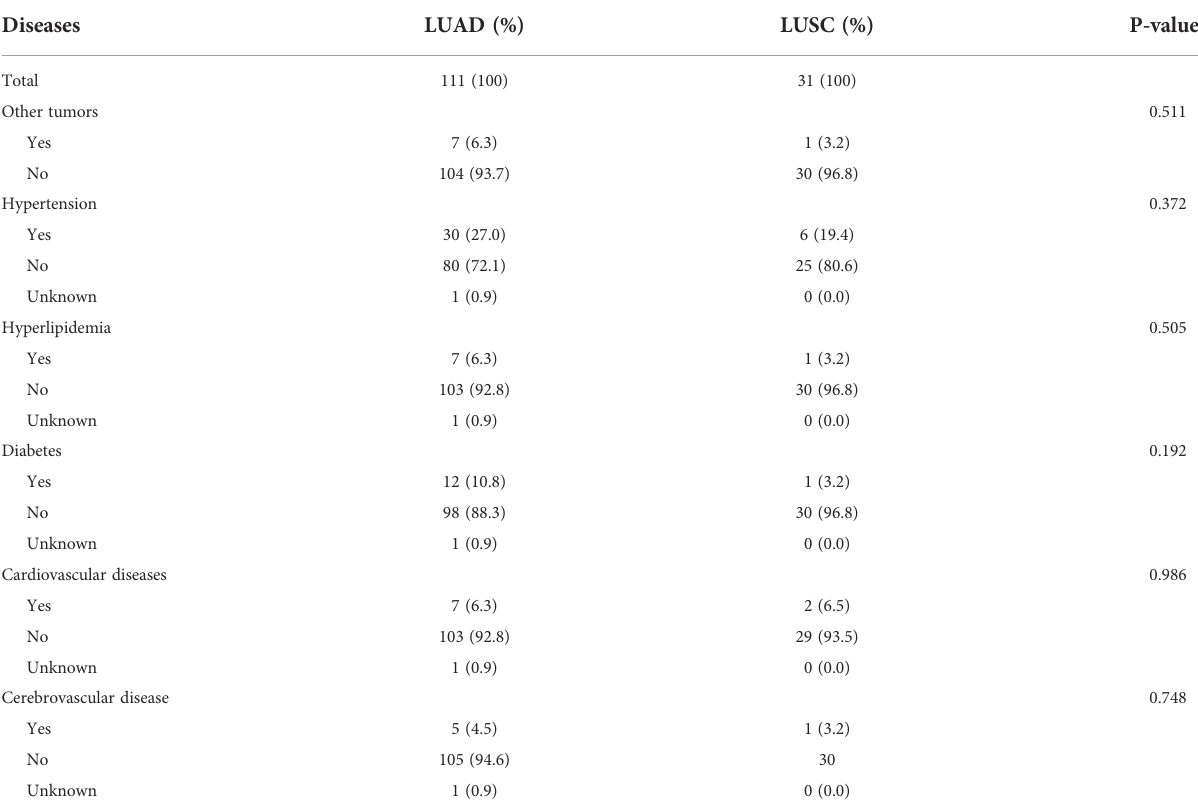
TABLE 4 History of other diseases of the patients.